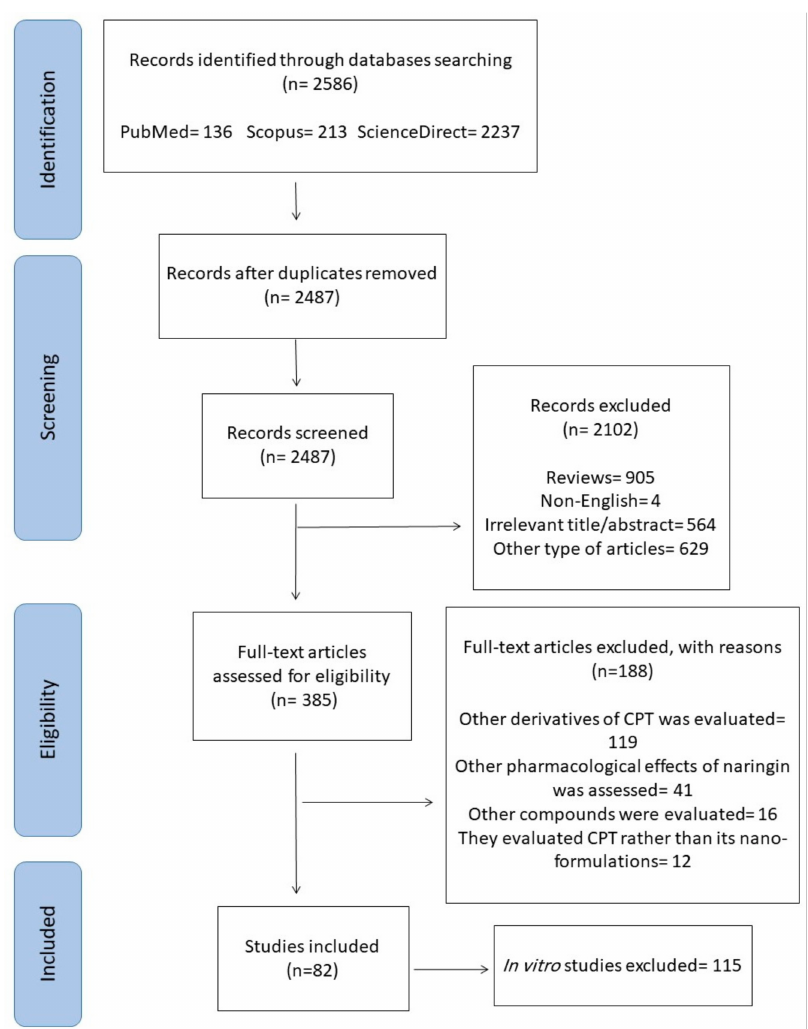
Figure 3. The PRISMA flow chart of the selection process for the included studies. 3. Anticancer Activities of Camptothecin Nano-Formulations Nano-CPT has been indicated to suppress different cancers via various mechanisms, such as growth suppression of malignant cells, induction of apoptosis and cell cycle arrest, and modulation of oxidative stress, angiogenesis, and inflammation. The anticancer effects of CPT nano-formulations in different cancers are provided in the next sections (Table